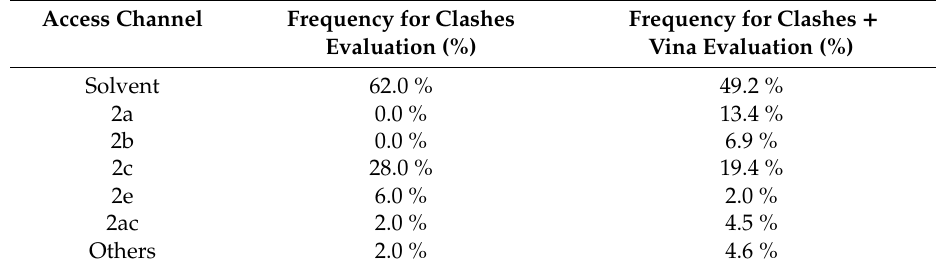
Table 3. Frequency of the different channels used by 0XV to access the binding site in CYP2C19. Percentage of solutions for each route with respect to the total of 50 runs is reported.